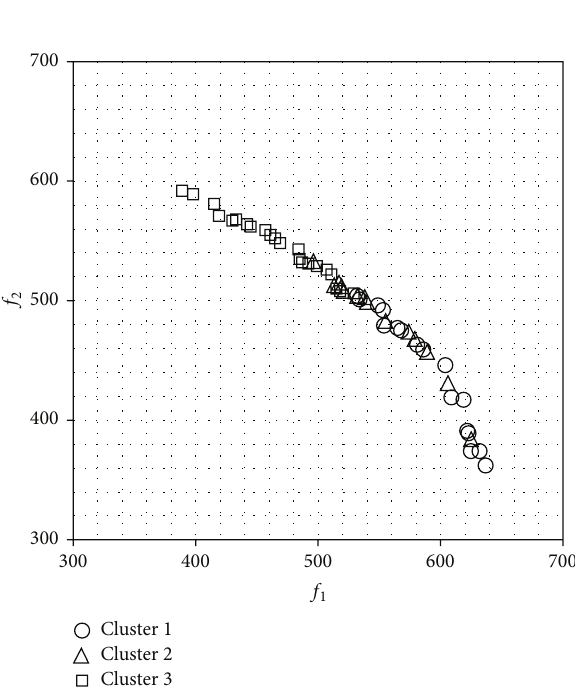
Figure 7: Three clusters obtained by 𝑘 -means